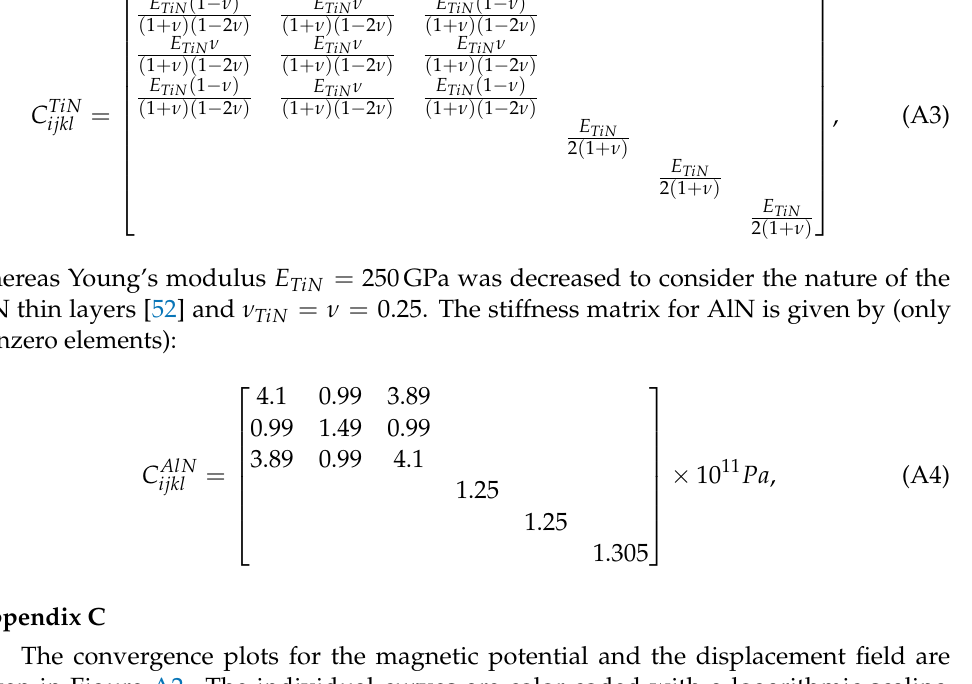
The convergence plots for the magnetic potential and the displacement field are given in Figure A2. The individual curves are color-coded with a logarithmic scaling. The tolerance limit used for the solver is marked at 10 − 6